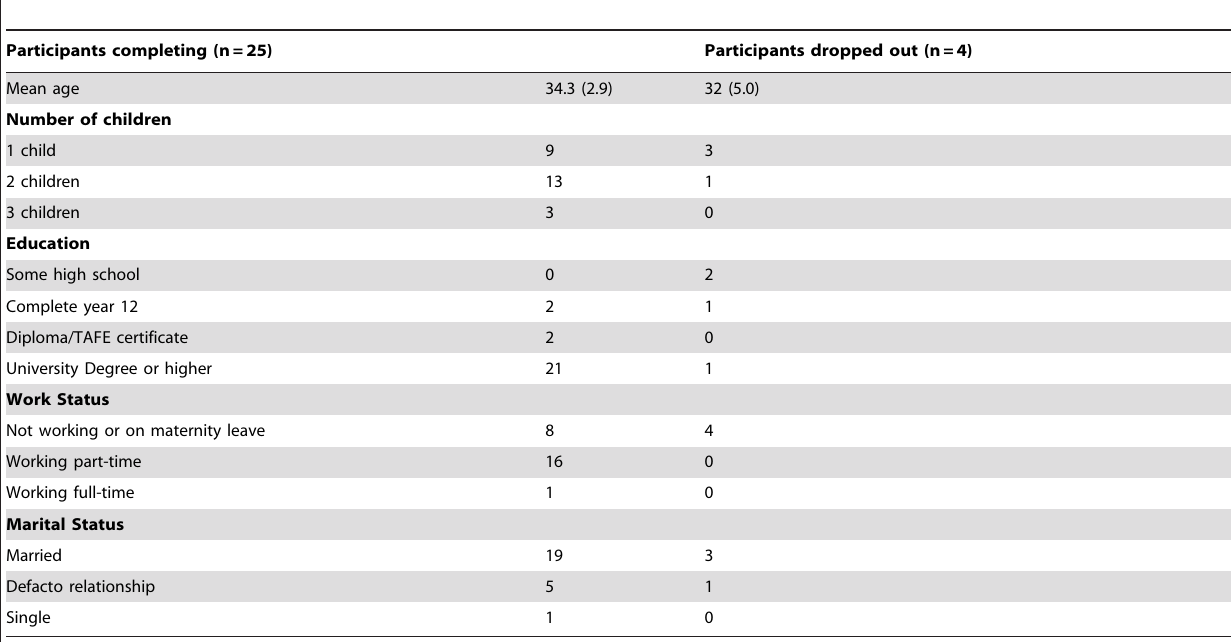
Table 2. Summarises the demographic characteristics of participants who completed and dropped out of the